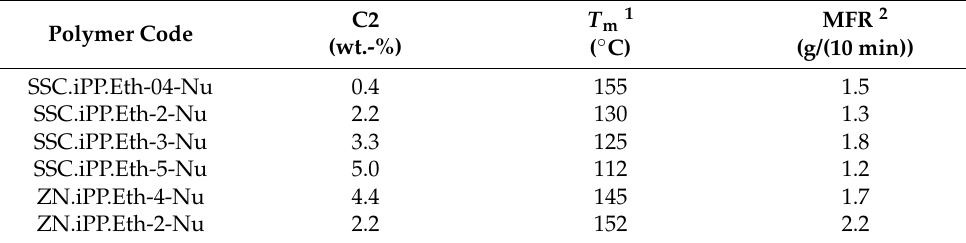
Table 2. Molecular characteristics of the nucleated samples of the present study. Polymer Code